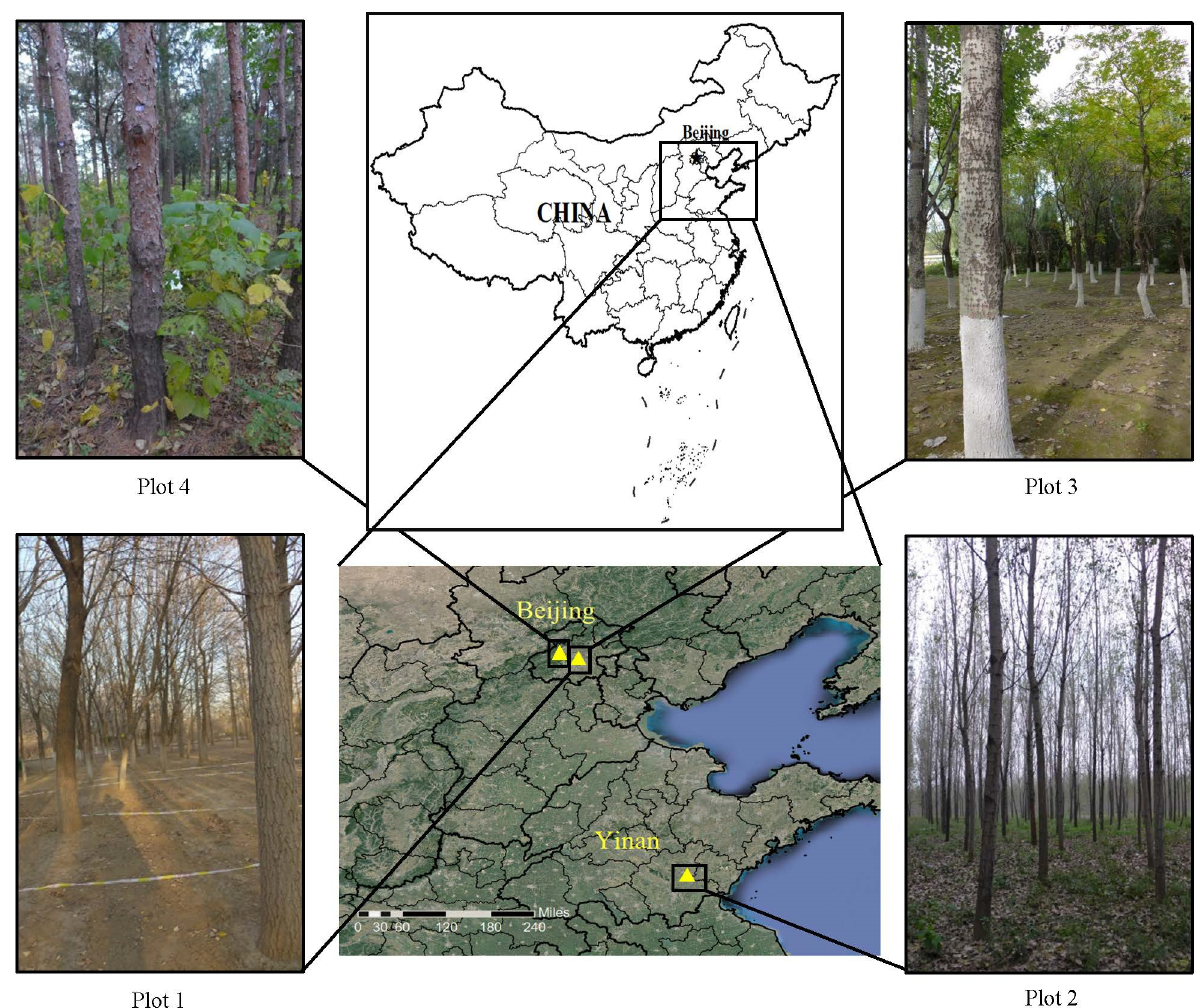
Figure 1. Forest sample plots in Beijing City and Yinan County, China.